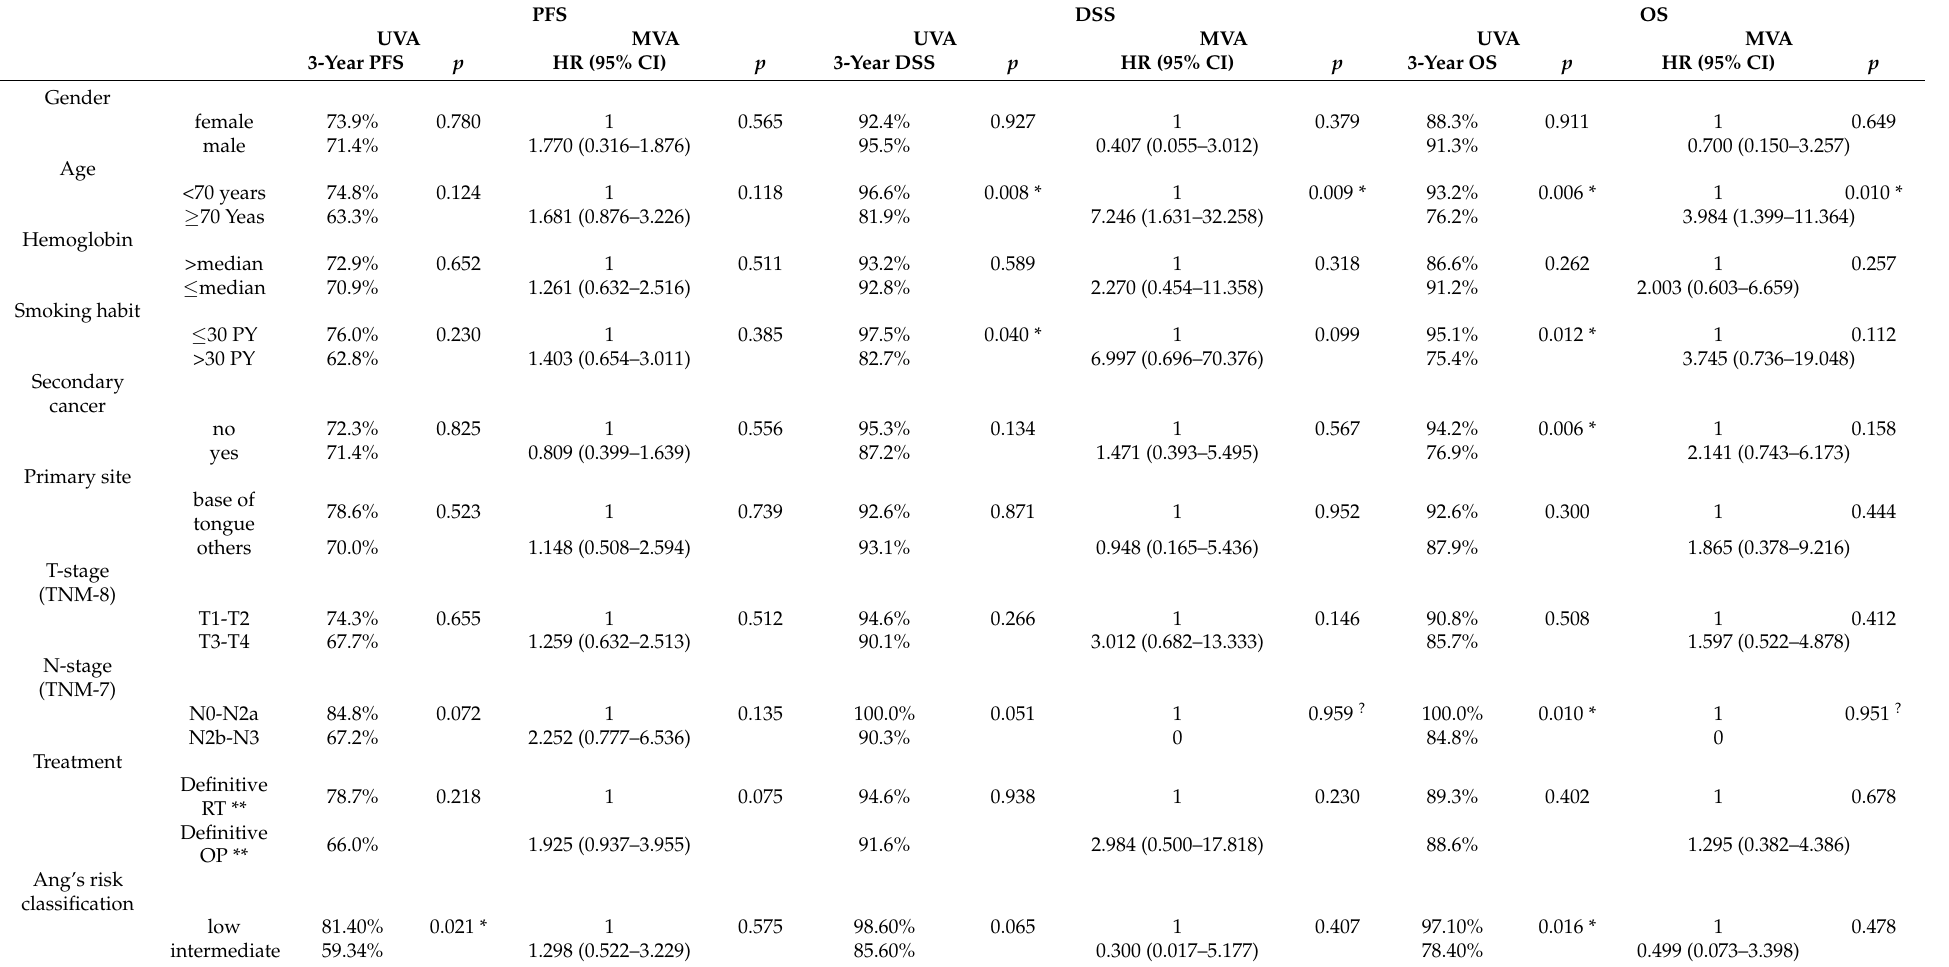
Table 2. Univariate and multivariate analysis using the selected variables with PFS, DSS, and OS as